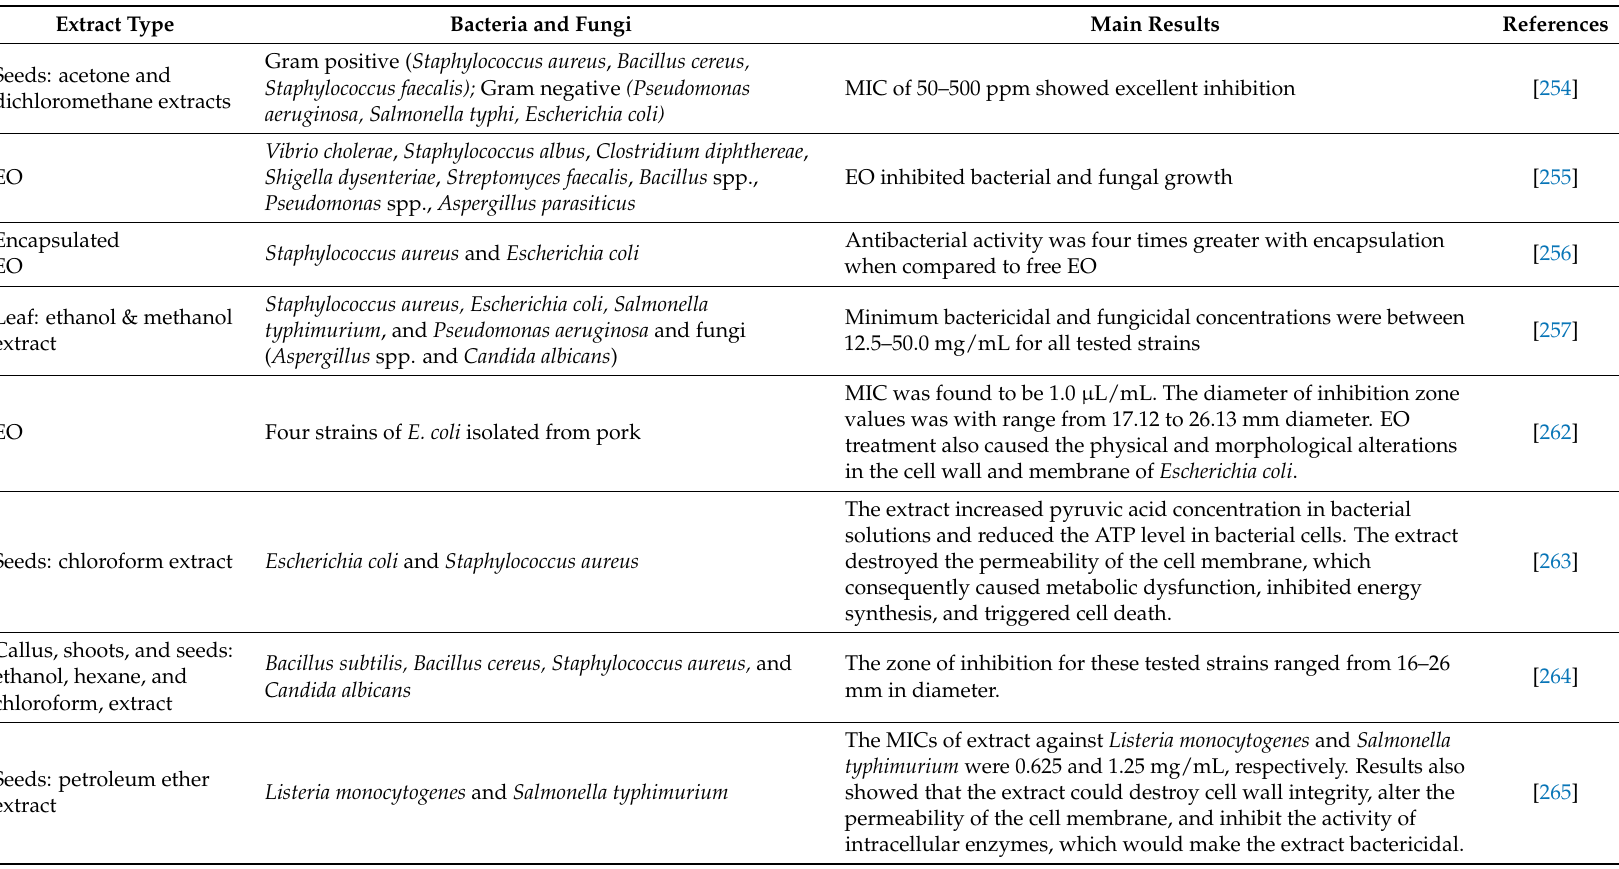
Table 28. Antibacterial and antifungal activities of P. nigrum L. (Black